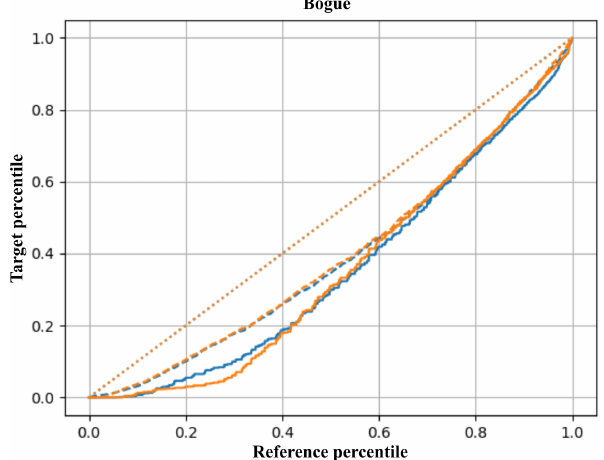
Figure 4. The transformation functions of the 1951–1960 FDC (solid) and API (dashed) to the target periods 1971–1980 (blue) and 1981–1990 (orange) for Amite. For the sake of comparison, the di- agonal is dotted in orange.